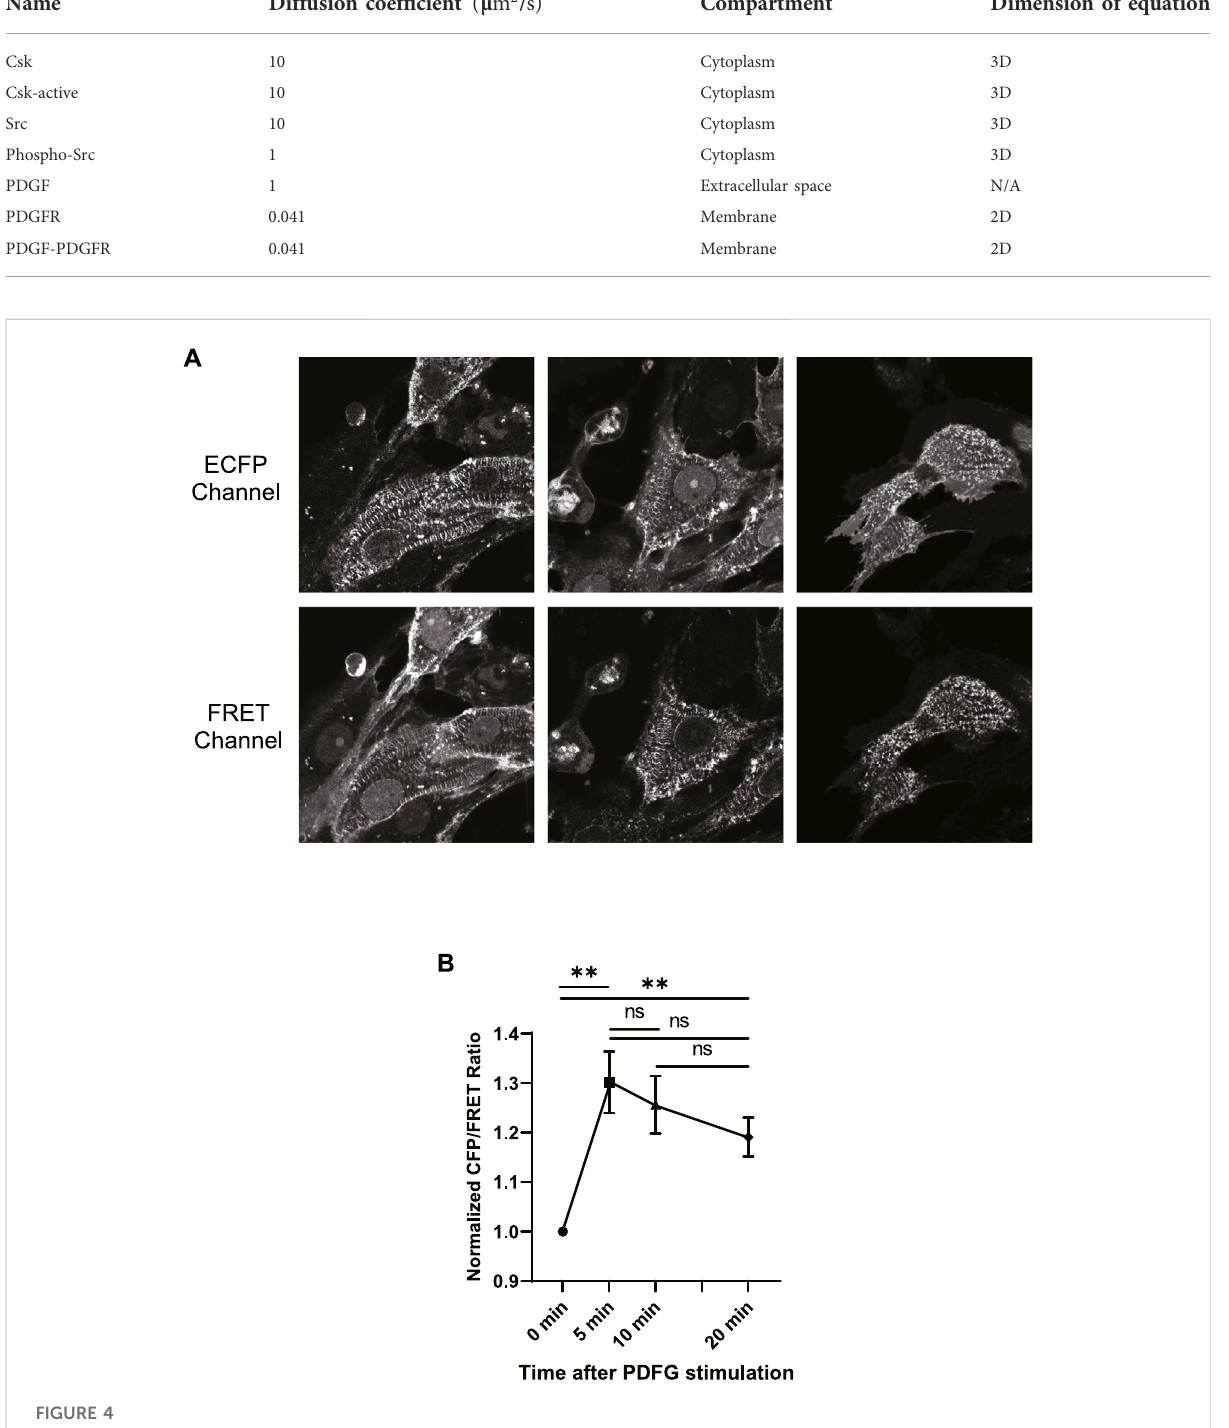
FIGURE 4 (A) Fluorescent signal images of ECFP and FRET emission channels acquired from three ECFP-YPet transduced NRCMs at t = 0+ of PDGF stimulation. (B) Normalized ECFP/FRET intensity ratios at t = 0+, 5, 10 and 20 min after PDGF treatment. Although, the ECFP/FRET values of time pointst=5,10,and20 min werenotsigni fi cantlydifferent(unpairedtwo-tailedt-test),comparedto eachother,theECFP/FRETvalues ofthesetime points were signi fi cantly higher, compared to t = 0+. The ECFP/FRET measurement was performed at the costameres pixels, using the approach described in the materials and methods